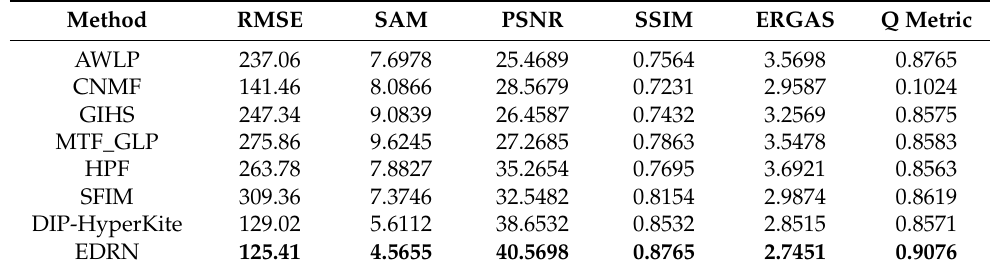
Figure 21. Quality of the compared and proposed fusion methods for the Chikusei dataset: ( a ) SCC; ( b ) spectral curve comparison. Table 4. Quality of the compared and proposed fusion methods for the Pavia Center dataset for RMSE, SAM, PSNR, SSIM, ERGAS and the Q metric.